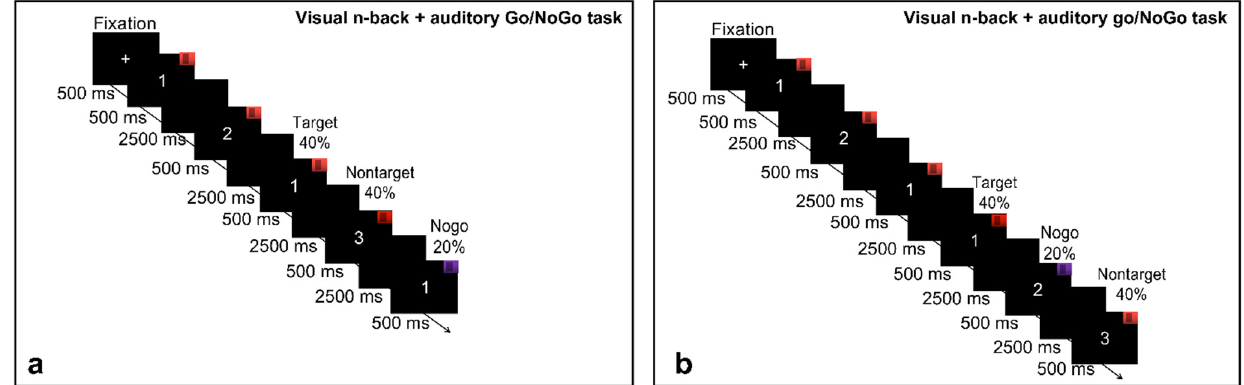
Figure 2. Dual-task schematic. ( a ) represents the audiovisual interaction working memory task in the 2-back condition, and ( b ) represents the audiovisual interaction working memory task in the 3-back condition.